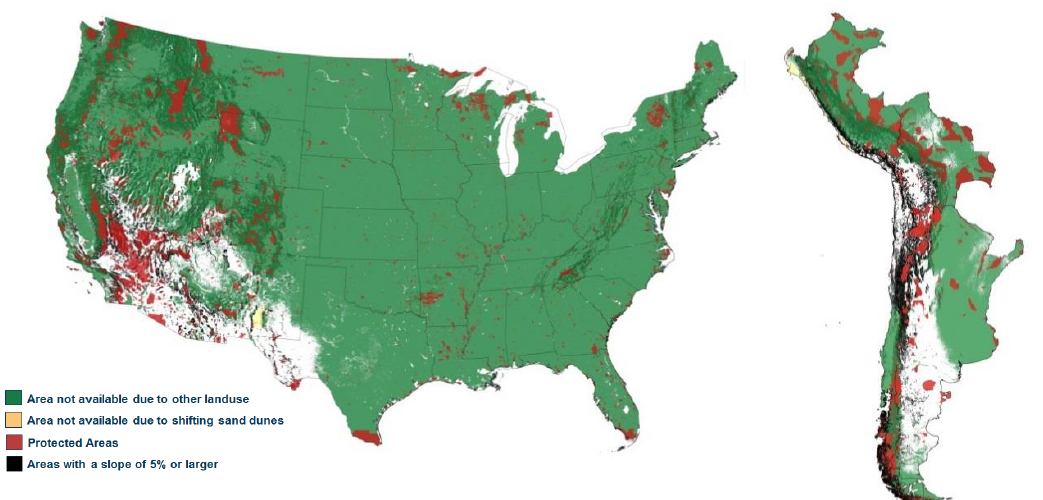
Figure 5. Suitable areas for solar thermochemical fuel production ( white ) in the USA ( left ) and Chile, Bolivia, Peru and Argentina ( right ). Excluded areas comprise other land use ( green ), protected areas ( red ), ≥ 5% slope ( black ), and shifting sands ( yellow ).